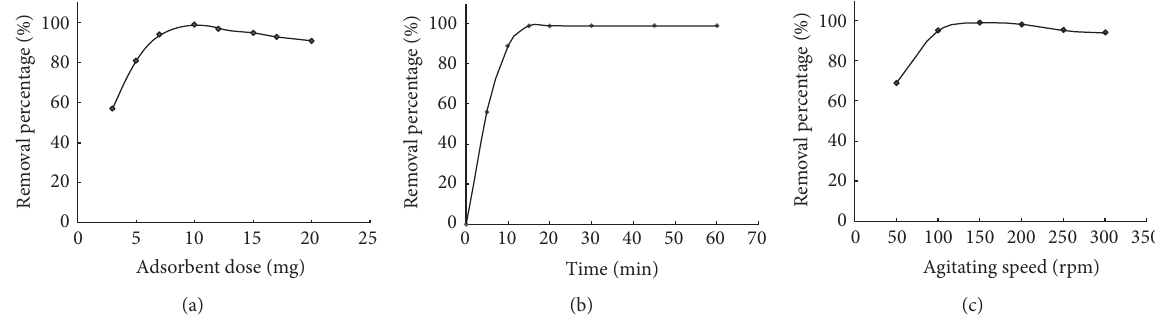
Figure 9: Effect of adsorbent dosage (a), shaking time (b), and agitating speed (c) on the removal percentage of Cu(II).